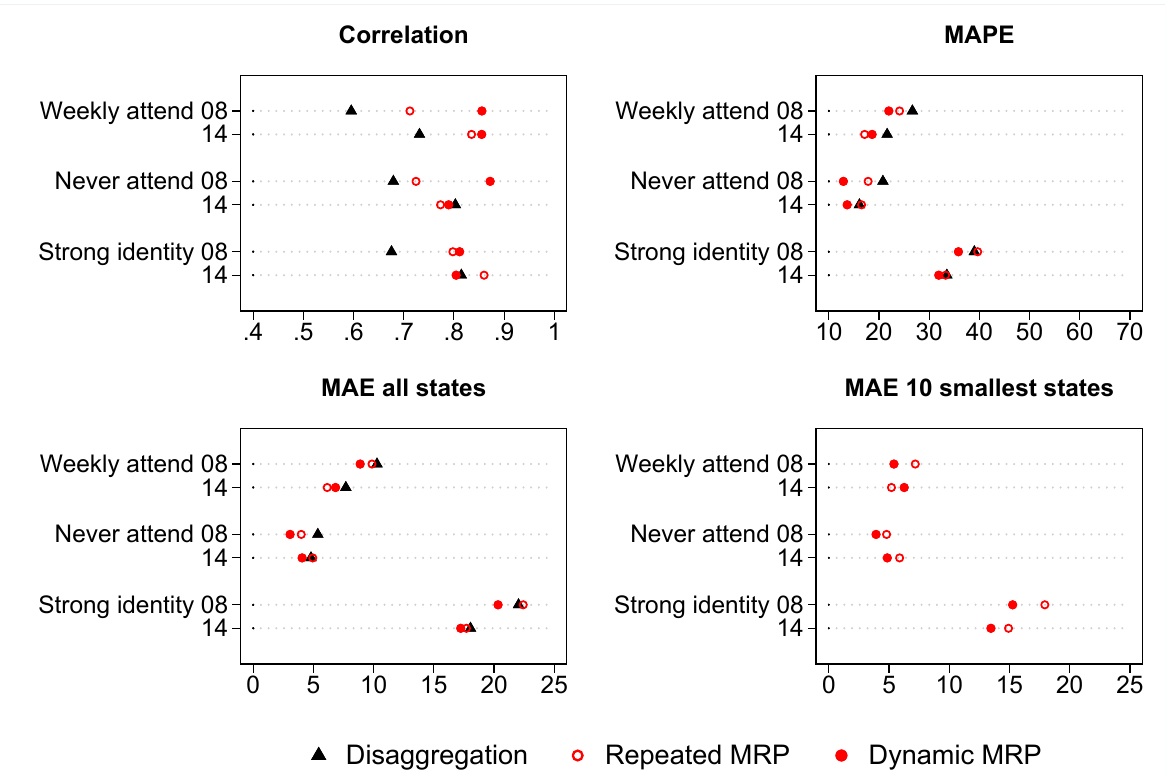
Figure 2: Comparisons of GSS-based estimates with external benchmarks: Frequency of religious service attendance and strength of identification. Notes: The reported statistics are based on all available estimates for a given year. Disaggregation provides estimates for 40 states in 2008 and 41 in 2014. Repeated MRP and Dynamic MRP provide estimates for all 50 states and the District of Columbia. The bottom-right panel considers the 10 smallest states by population size other than Alaska, Hawaii, and District of Columbia, which have been ignored to ensure consistent samples over